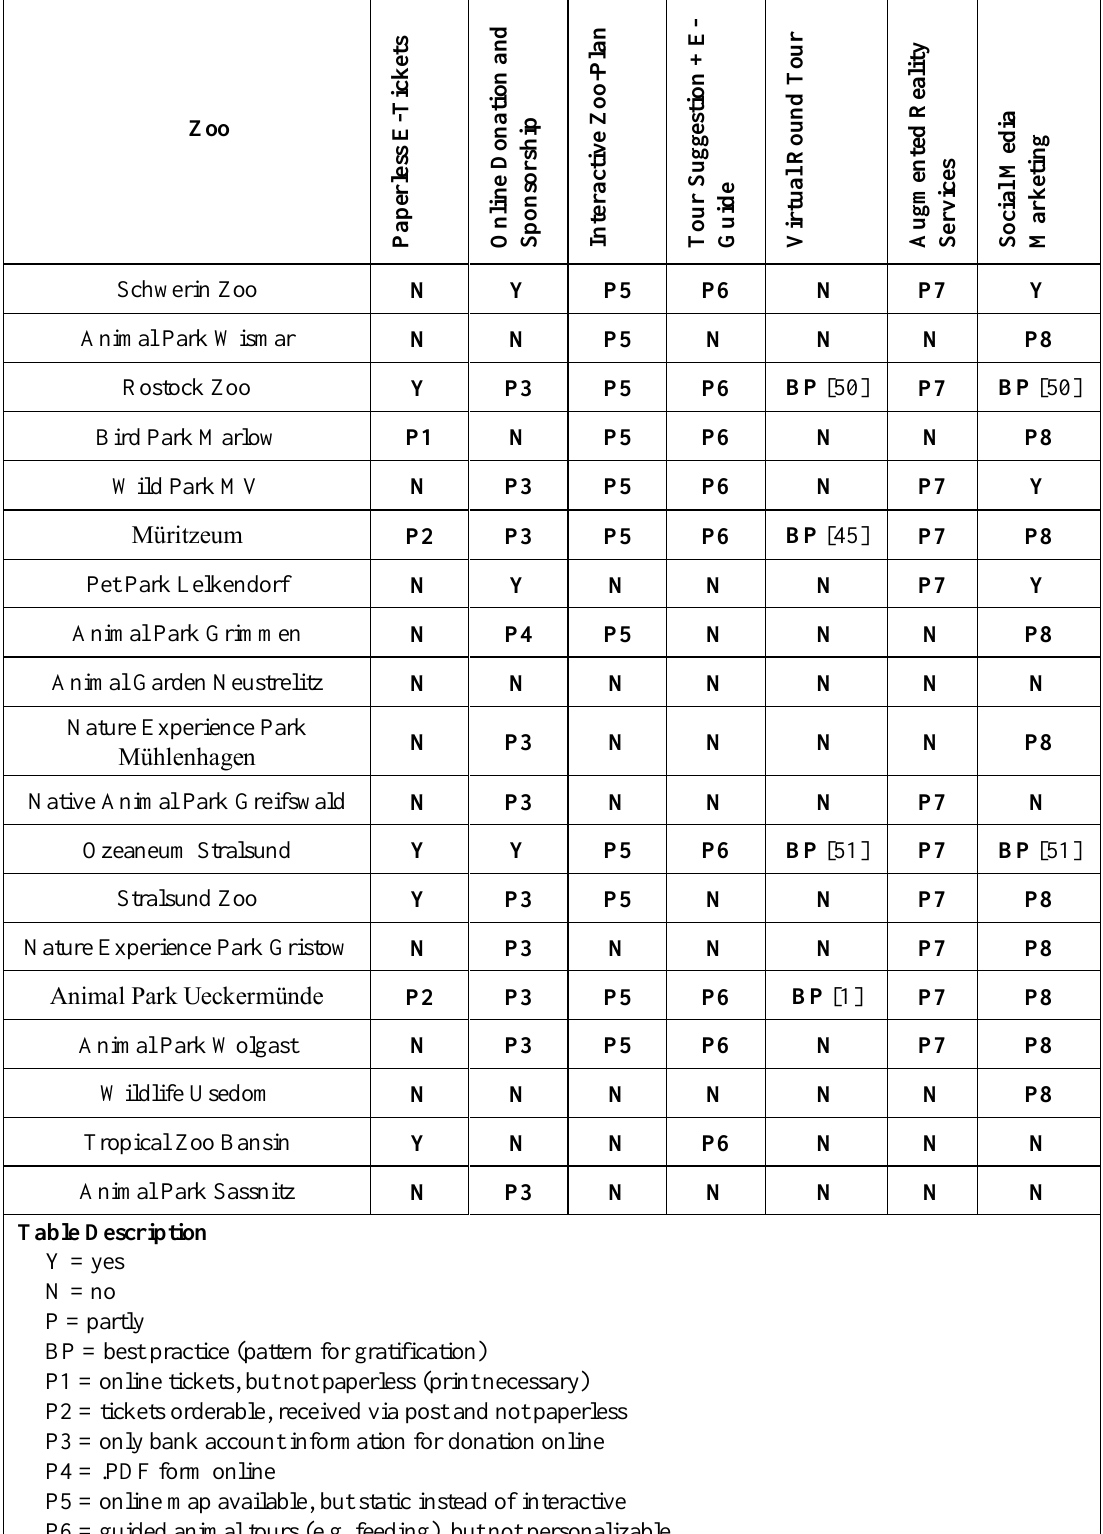
Table 2. Digital Potentials and Actions Zoos “Landeszooverband Mecklenburg-Vorpommern e.V. ”